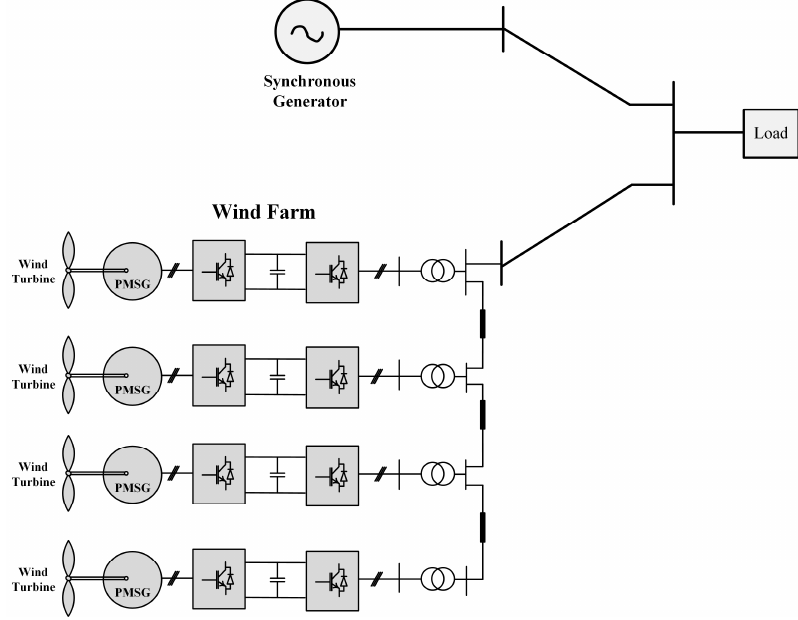
Figure 6. Power system model with a wind farm of 4 wind turbine systems.